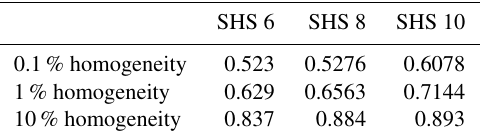
Table 2. Axisymmetric coil homogeneity study: comparison be- tween several coil configurations: SHS 6, SHS 8 and SHS